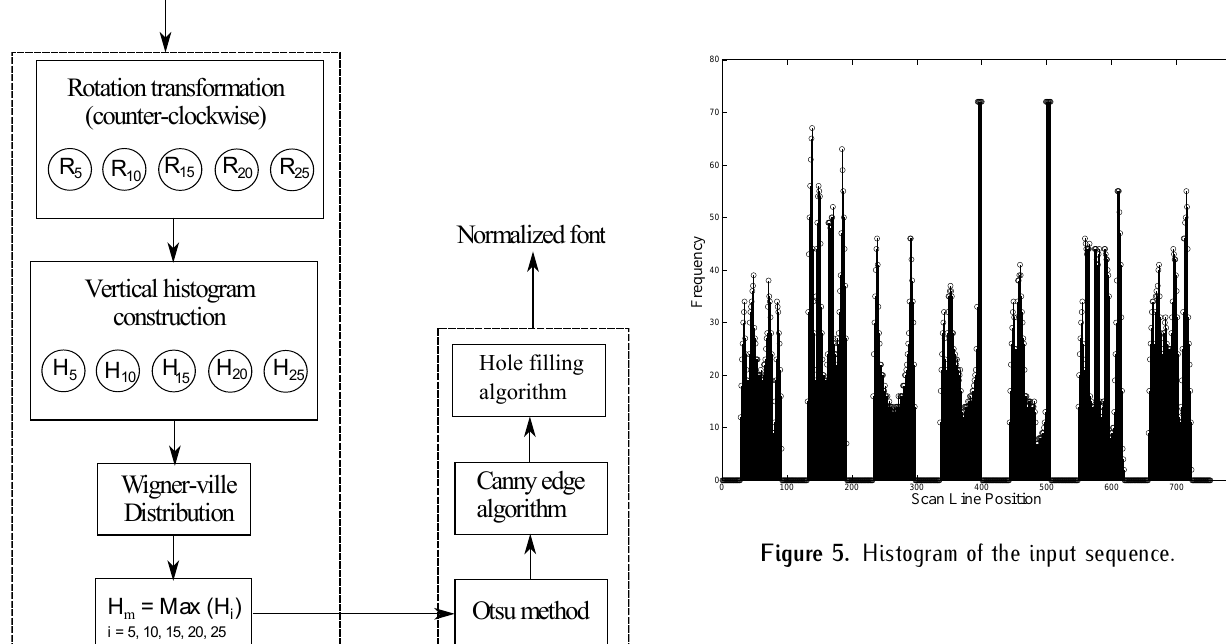
Figure 4. A sample input string of Odia characters.